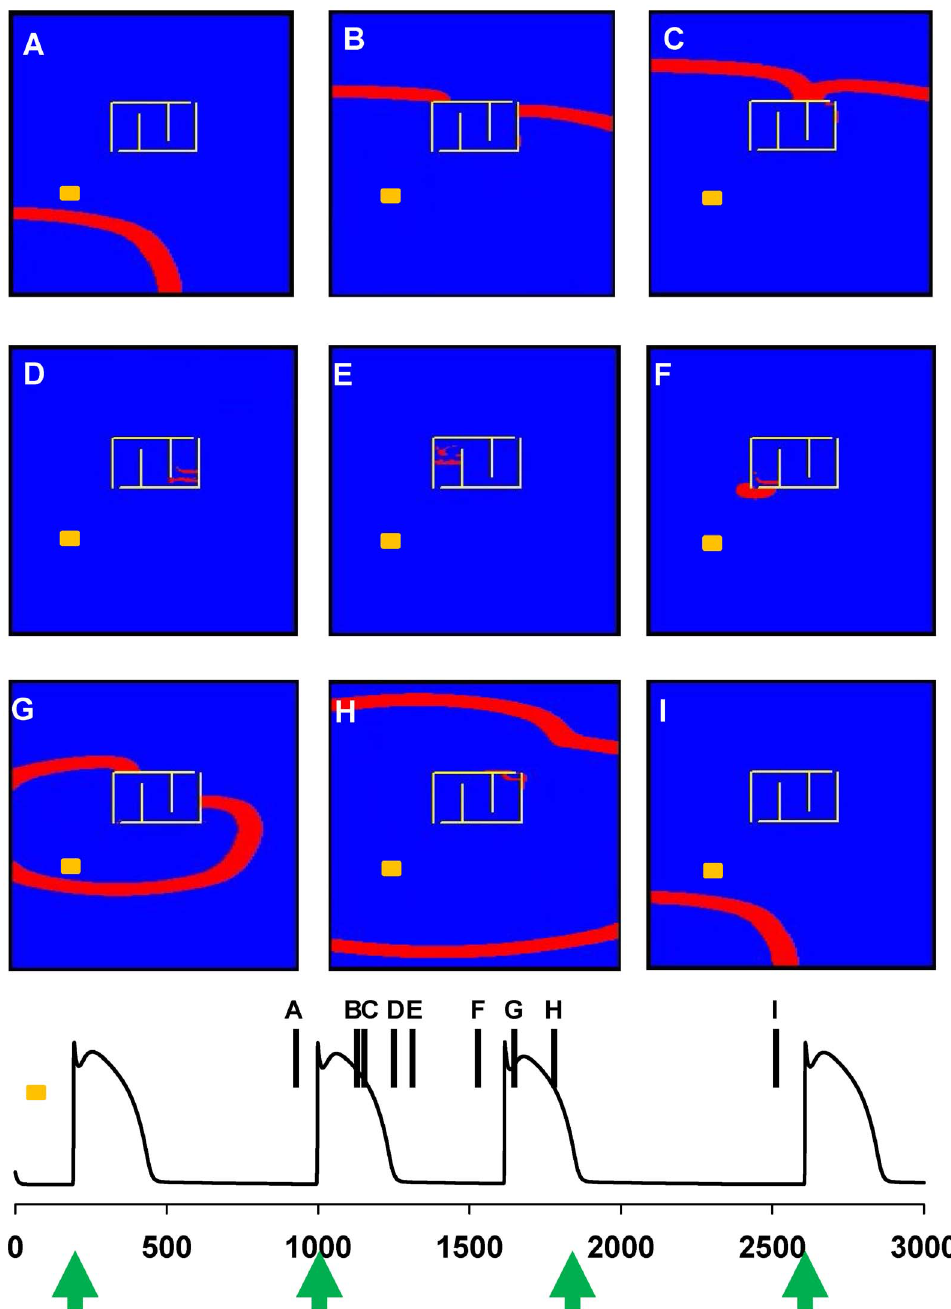
Figure 3. Typical onset of a premature beat. A–I) snapshots from Movie S2, illustrating the propagation of two normal beats (panels A-B-C and I) and a premature beat (panels D through H); (bottom plot): membrane potential of cell(25,100), marked in yellow in the snapshots, during the simulation shown in Movie S2. Vertical markers show the time points at which the snapshots in panels A-I were taken.